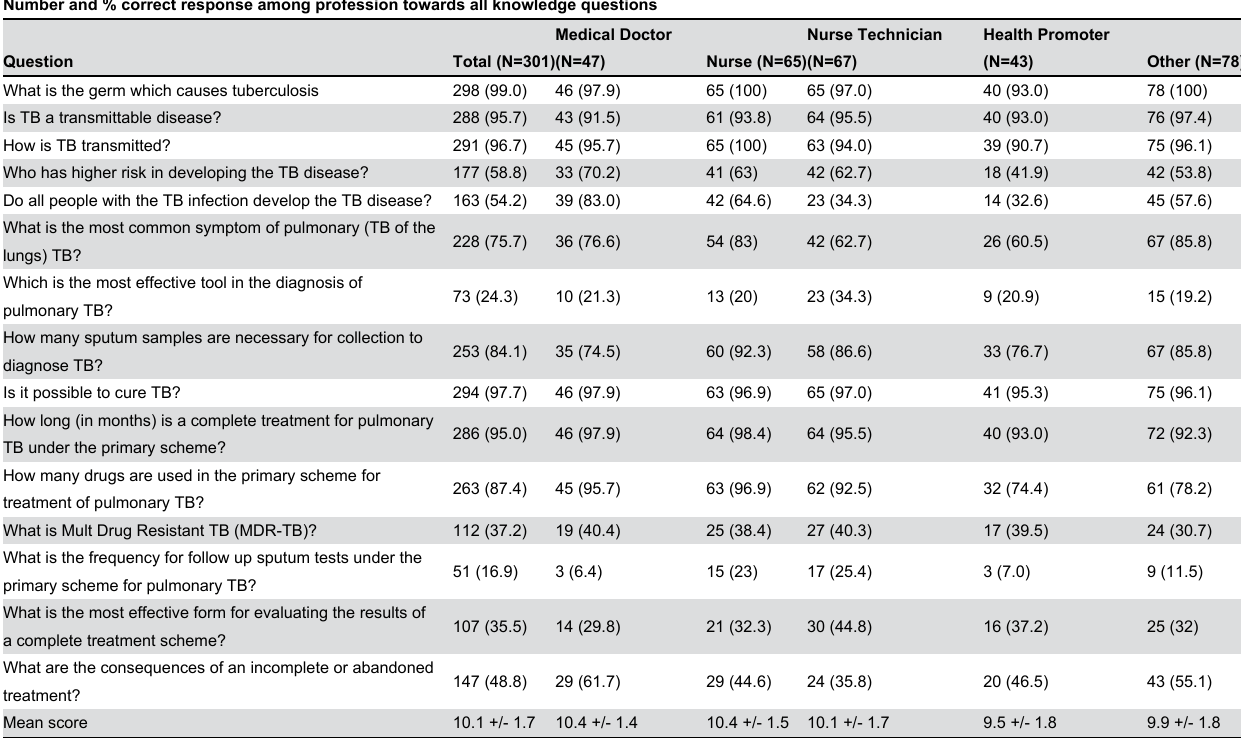
Table 2. Knowledge Scores total and by